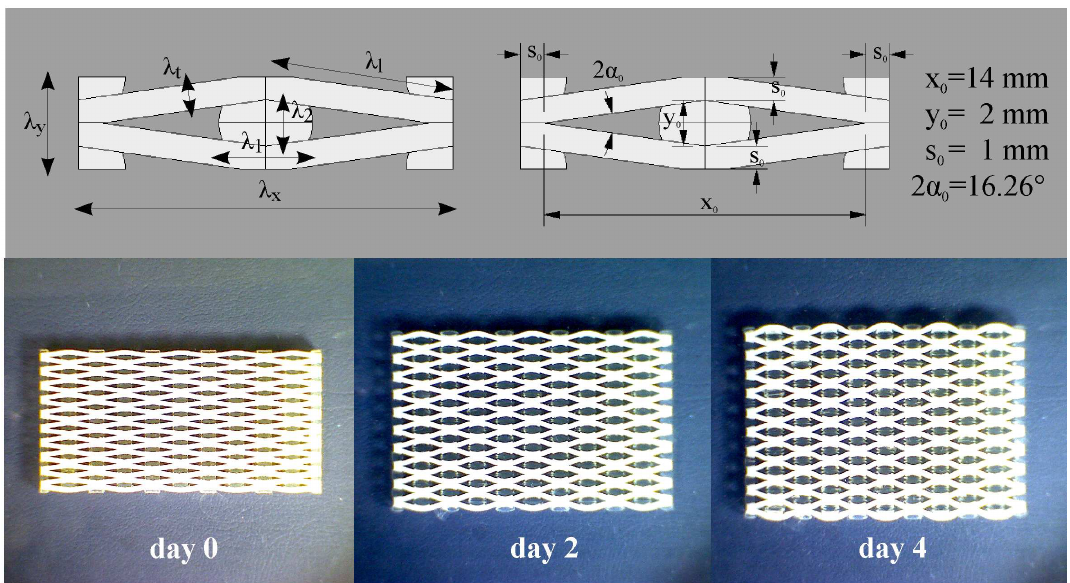
Fig 3. Swelling of a honeycomb with stiff (MW4) walls and soft (MI) inclusions. The honeycomb’s unit cell geometry is reported with the kinematic variables(upper left) used in the analytical model and the actual dimensions(upper right). Swelling of a diamond-shapedhoneycombwith”stiff” walls (G walls = G MW4 = 176.7 MPa) and soft cell inclusions(G inclusions = G MI = 0.135 MPa). Snapshots cover 4 days of swellingin isopropanolat room temperature(T =